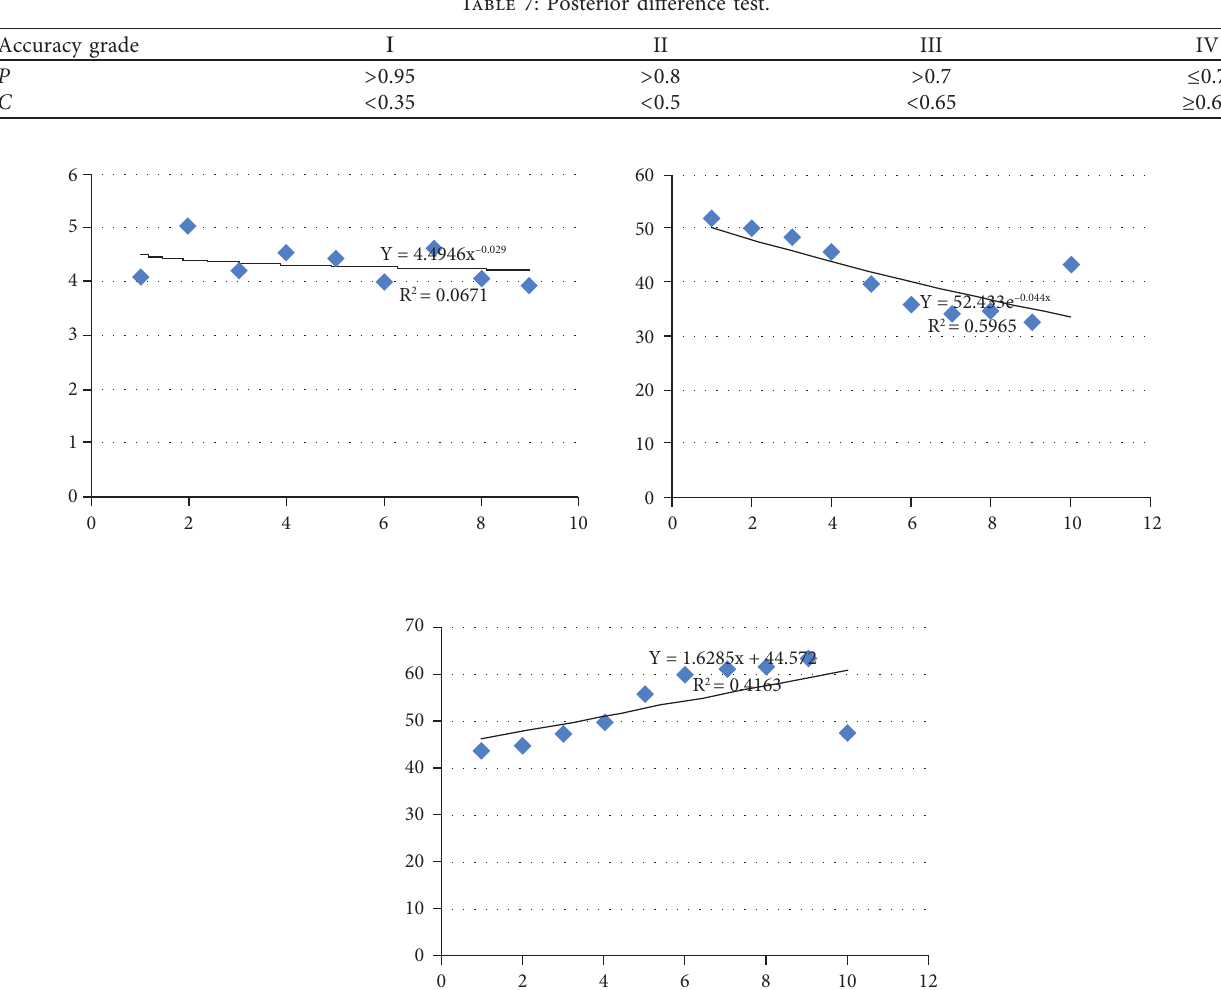
Table 7: Posterior difference test.